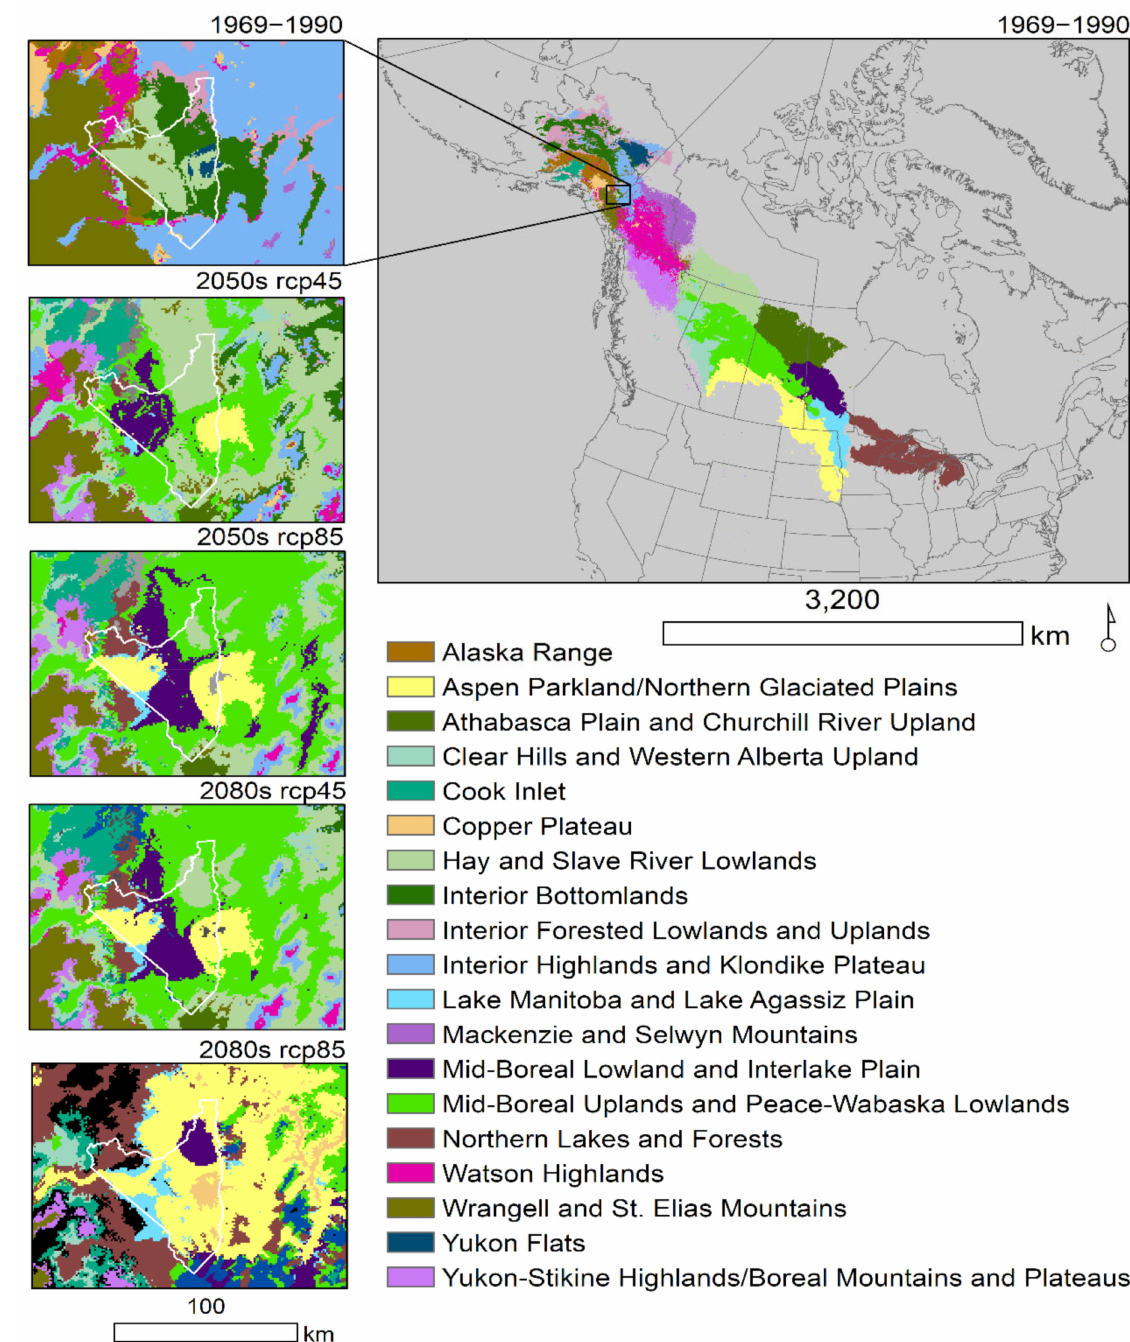
Figure 5. Ecoregional climate envelop model developed by Stralberg [56]. The model is based on bioclimatic variables using the 1961–1990 climate normals and forecast to climate futures in the 2050s and 2080s using CMIP5 rcp4.5 and rcp 8.5 emission scenarios and a 15-model ensemble. The boundary of the Tetlin National Wildlife Refuge, Alaska is the focus of the zoomed in